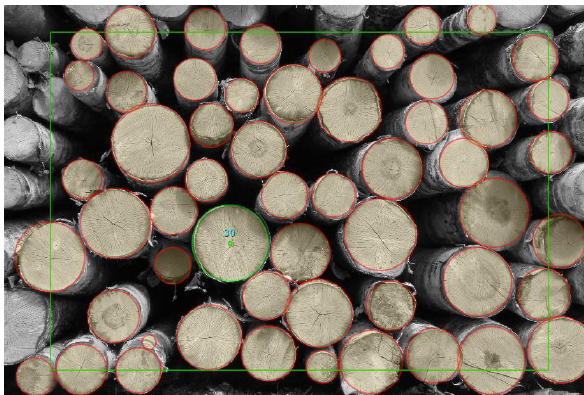
Figure 7. Result of work of accumulator for circle hypotheses Then corresponding points for circles centres are detected in the right image. For this purpose the left and the right images are rectified and corresponding points in the right image are searching by correlation technique using information about probable location of corresponding point from epipolar geometry and possible depth diapason (Figure 8).